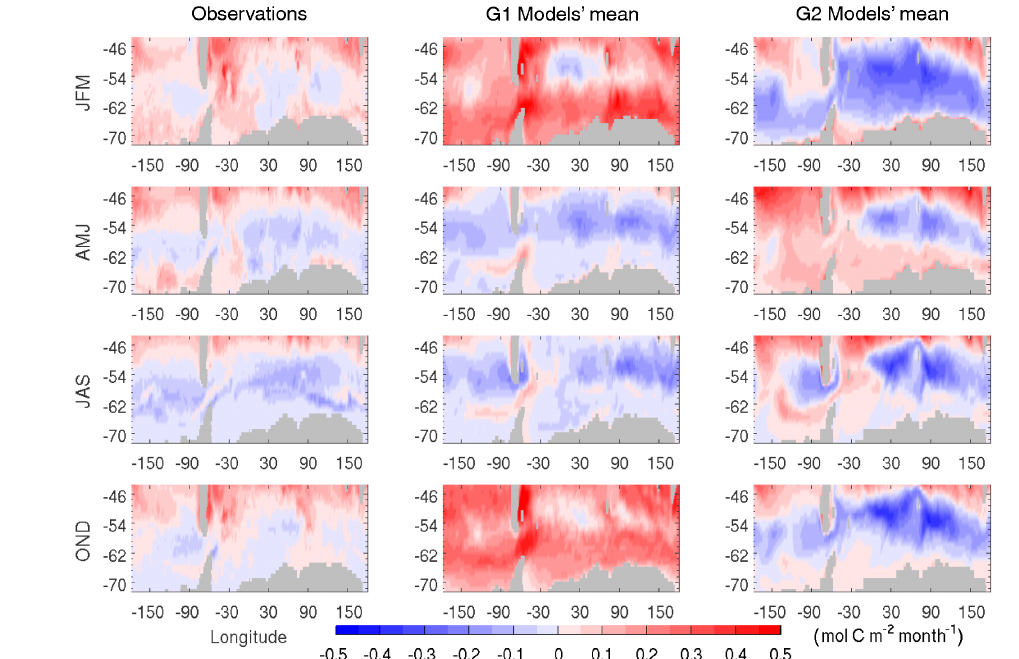
Figure 8. Contemporary (2001–2010) seasonal mean of air–sea CO 2 fluxes from (first column) observations-based estimates of Landschützer et al. (2014), (second column) G1 models, and (third column) G2 models. Each row of panels depicts values for different seasons (JFM, AMJ, JAS, and